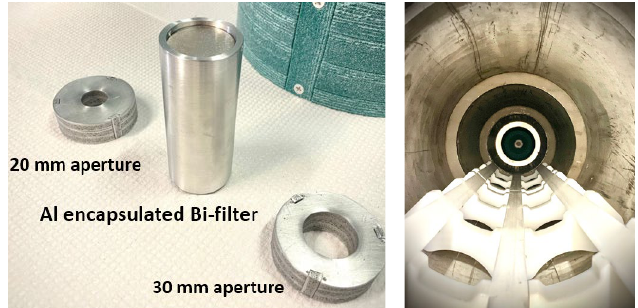
Fig.3. Collimator components for the RSEC – NIF beam port: Bi single crystal in the aluminum encapsulation and two boral apertures (left), installation of the lead and poly steps using the in-house 3D printed delivery rails (right).